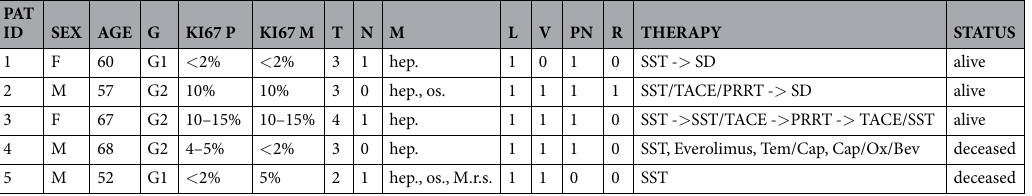
Table 1. Patient characteristics. Clinical characteristics of the study cohort. P: primary, M: metastasis, hep: hepatic, os: osseous, M.r.s.: Musculus rectus superior, SST: somatostatin analogue, TACE: transarterial chemoembolization, PRRT: Peptide Receptor Radionuclide Therapy, Tem: temozolomide, Cap: capecitabine, Ox: oxaliplatin, Bev: Bevacizumab, SD: stable